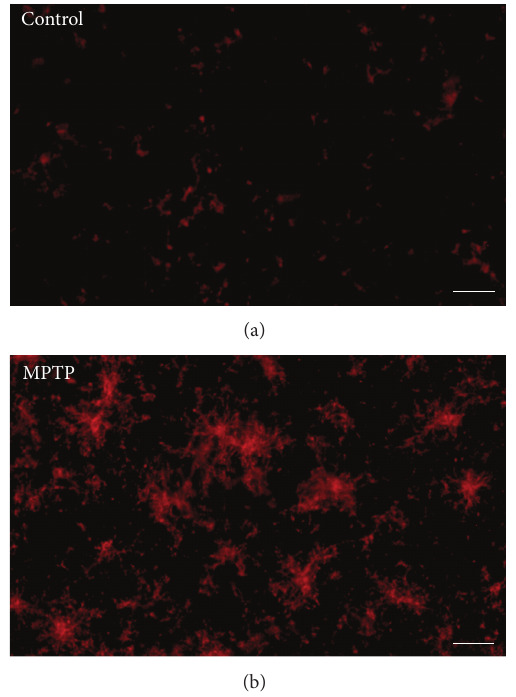
Figure1:AcuteMPTP-inducedmicroglialactivationinthestriatum of adult mice. (a) Microglia in resting condition in control and (b) activated microglia in MPTP treated animals. MPTP was dissolved inphysiologicalsalineandadministeredsubcutaneously(s.c.)adose of10 mg/kgevery2 hrforatotalof4injections.Micewerekilled48 h after last injection and processed for immunofluorescence staining. Microglia were labeled with MAC-1 antibody. Scale bar = 400 𝜇